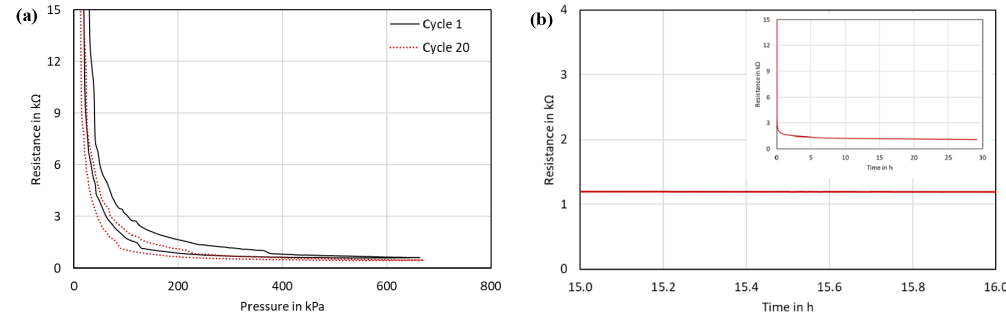
Figure 6. (a) Repeatability of the sensor after 20 continuous pressure cycles. (b) Stability of the sensor at a constant load of 25N over